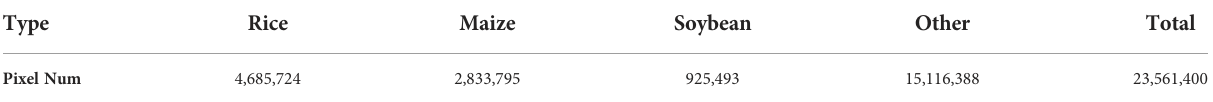
TABLE 1 Dataset